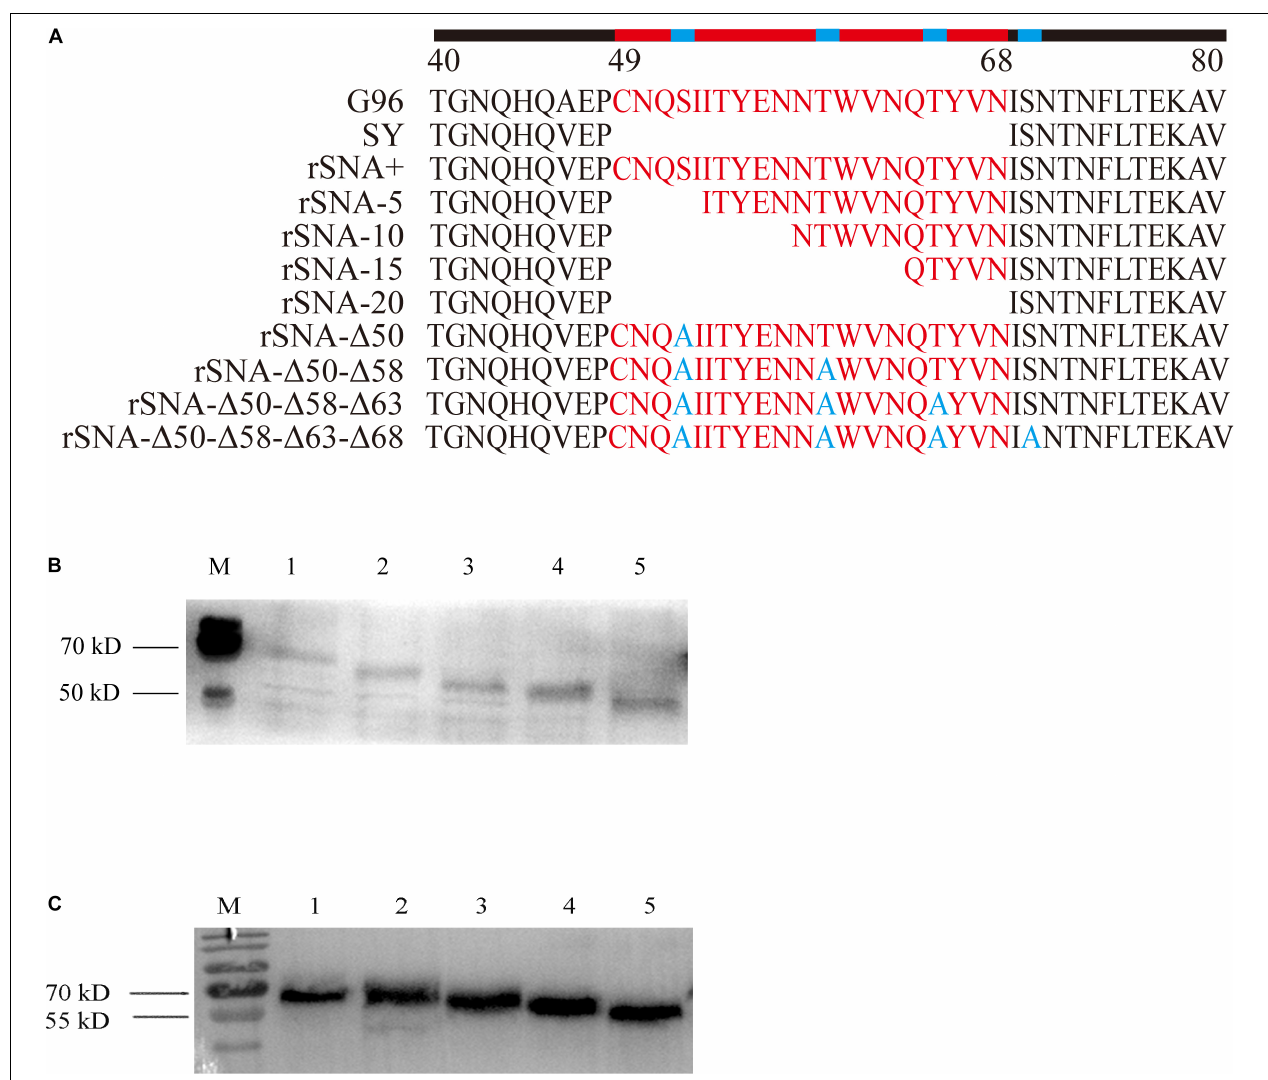
FIGURE 1 | SY NA stalks mutant viruses and their western blot analysis. (A) SY and their NA stalk mutant viruses were generated by reverse genetics based on the NA stalk truncation or deglycosylation strategy. (B) Four recombinant viruses with different glycosylation patterns in the stalk of the NA and rSNA+. 1–5: